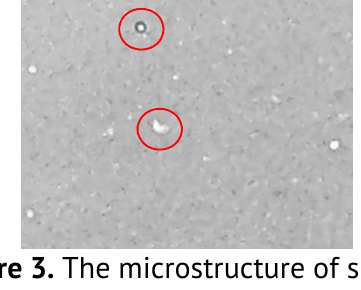
Figure 2. The microstructure of spread kept 30 days at t = (3 ± 2)ºC.